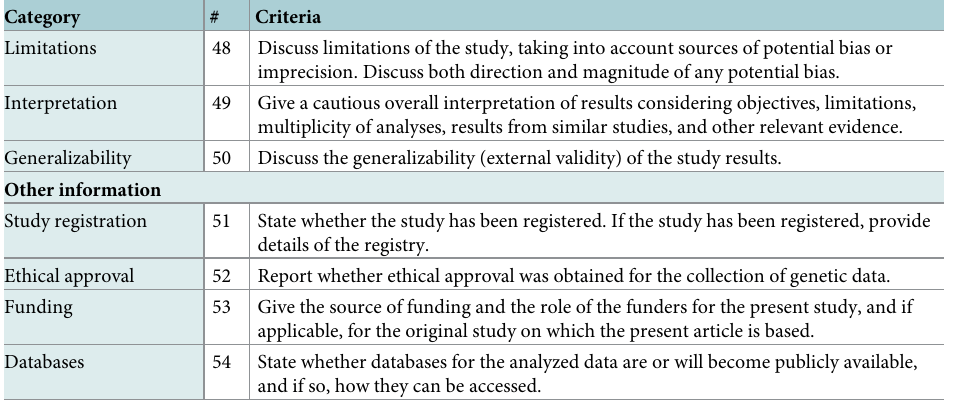
S3 Table. Summary of decisions made at consensus